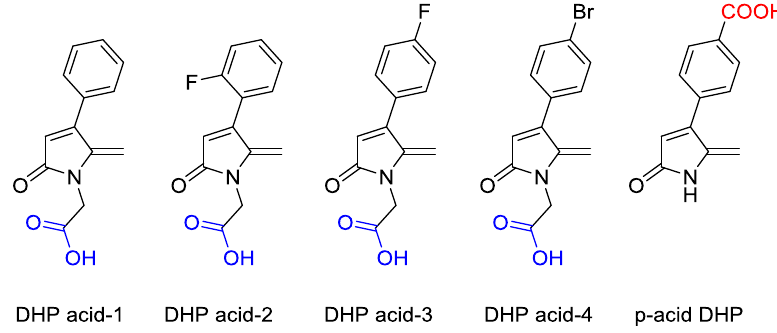
Figure 2. Chemical structures of DHP derivatives synthesized.